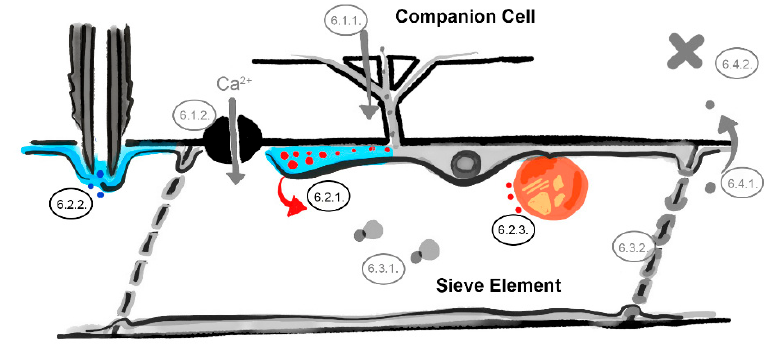
(Section 6.2.1), occlusion of aphid stylets (Section 6.2.2), and plastid-located defenses (Section 6.2.3). Figure 3. The parietal layer–phloem sap interface barrier. Defenses in the sieve element reticulum Involved barriers are indicated in color (light blue = sieve element reticulum, dark gray = aphid (6.2.1.), occlusion of aphid stylets (6.2.2), and plastid-located defenses (6.2.3). Involved barriers are stylets, dark blue = aphid saliva, red dots = virus identities, orange sphere = phloem plastid, numbers indicated in color (light blue = sieve element reticulum, dark gray = aphid stylets, dark blue = aphid correspond to the listed mechanisms in the main text, image not drawn to saliva, red dots = virus identities, orange sphere = phloem plastid, numbers correspond to the listed mechanisms in the main text, image not drawn to scale).